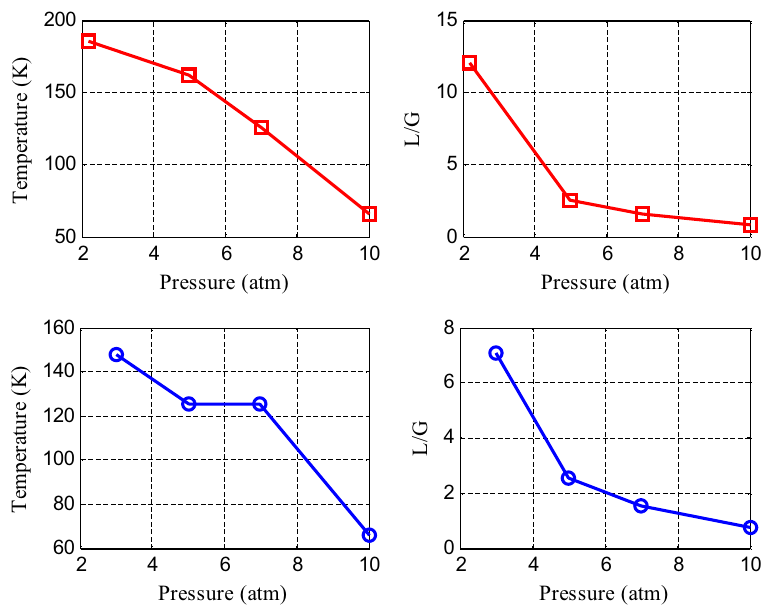
Figure 2: CO 2 capture process performance at selected values for P a using DES: squares for 90% recovery and circles for varied recovery.